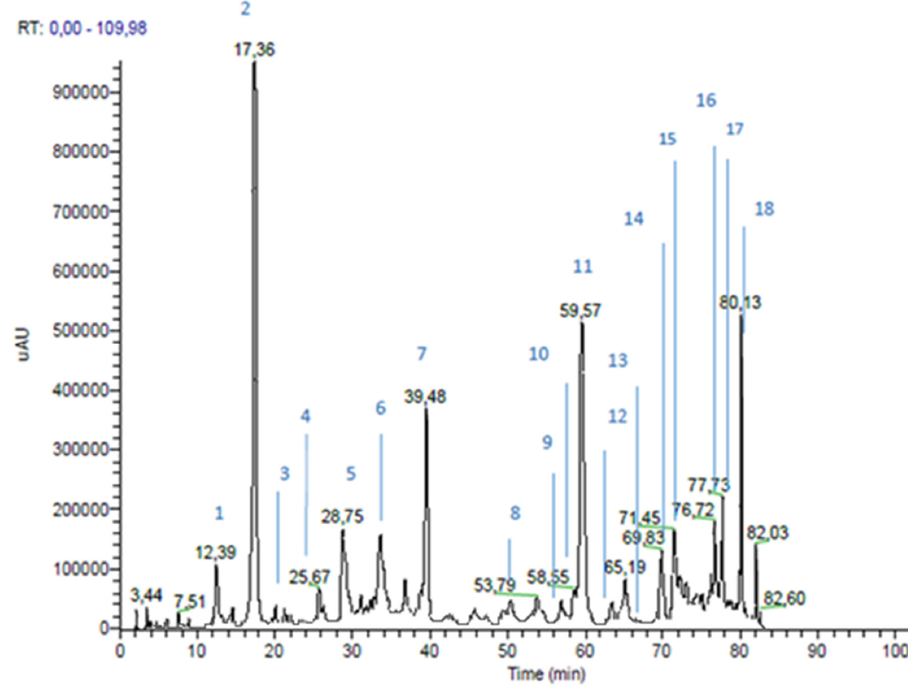
Figure 1. Green propolis extract chromatogram, registered at 330 nm.